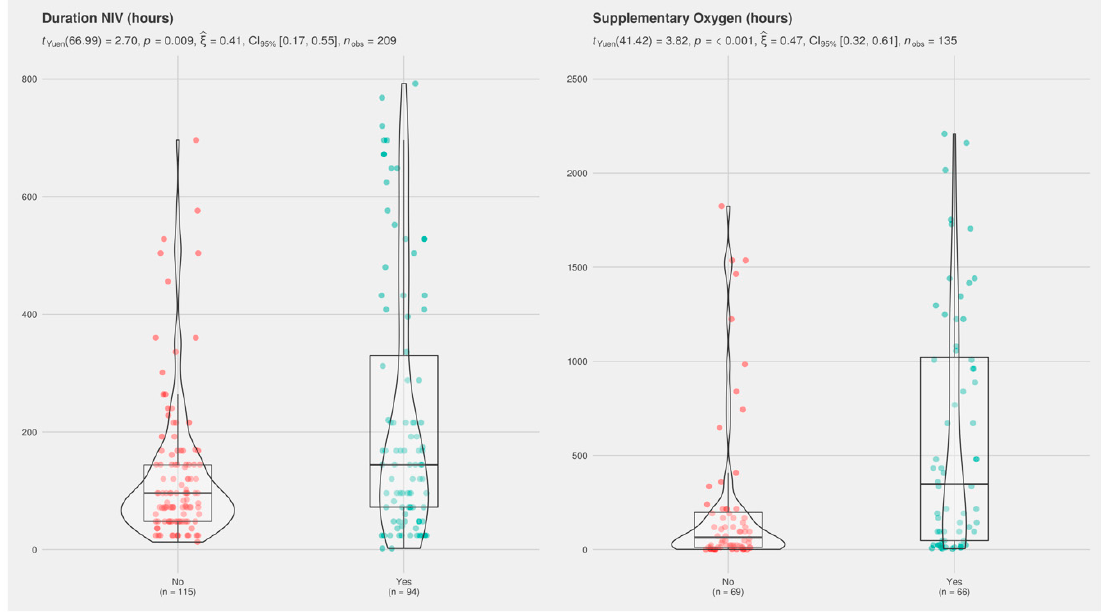
Figure 3. Boxplot merged with a violin plot (a rotated kernel density plot on either side) comparing duration of noninvasive ventilation (NIV) and supplementary oxygen in infants with high versus low risk for metabolic bone disease (MBD). ‘Yes’ indicates high-risk for MBD patients and ‘No’ indicates low-risk patients. In box plots, the boundary of the box closest to zero represents the 25th percentile, the line within the box represents the median, and the boundary farthest from zero represents the 75th percentile. Lines above and below the box represent the 10th and 90th percentiles, respectively. Red and green dots represent the variable in question for cases and controls, respectively. Corresponding mean and interquartile ranges for each variable are provided in Table 2. Violin plots represent kernel density estimation and depict the distribution shape of the data; the probability that infants of the population will take on the given value is higher in wider areas and lower in narrower areas.